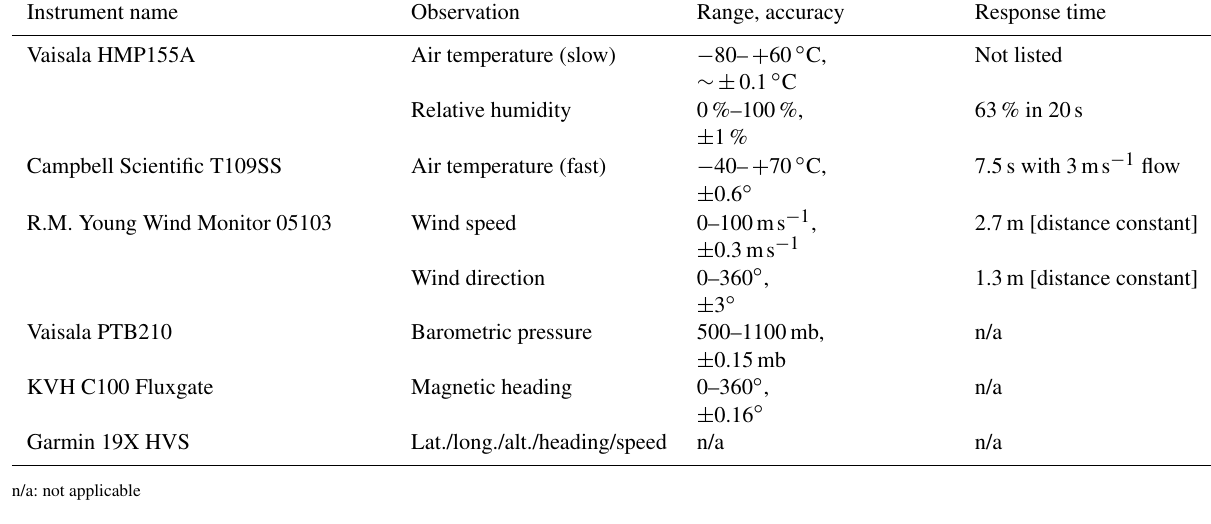
Table 2. Sensor specifications for the NSSL MM and UNL CoMeT vehicles.